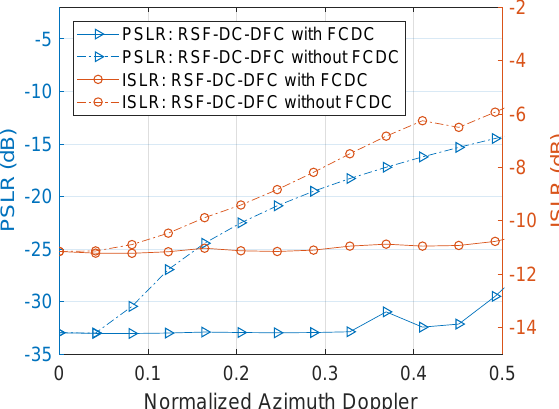
Figure 9. PSLR and ISLR as a function of the normalized Coarse Doppler.